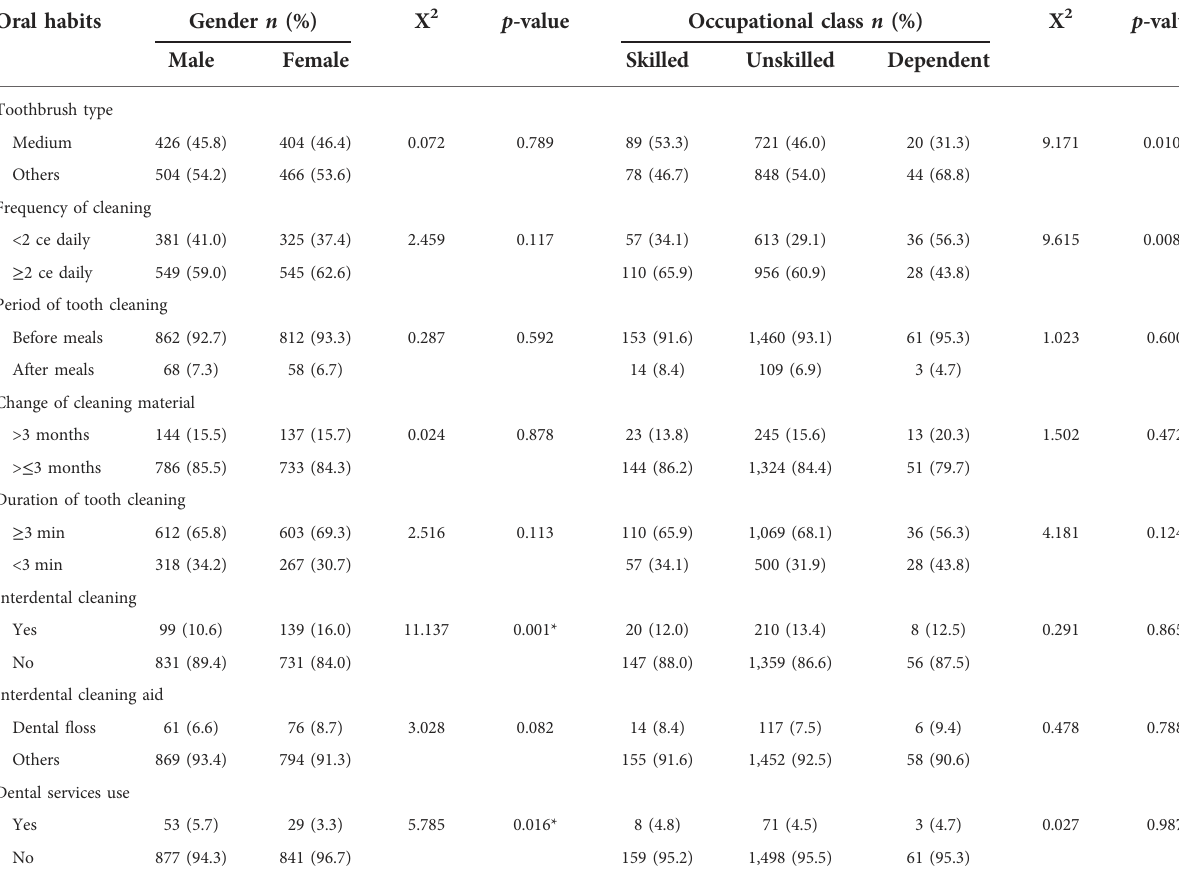
TABLE 2 Oral hygiene habits and sociodemographic characteristics of the adolescents. Oral